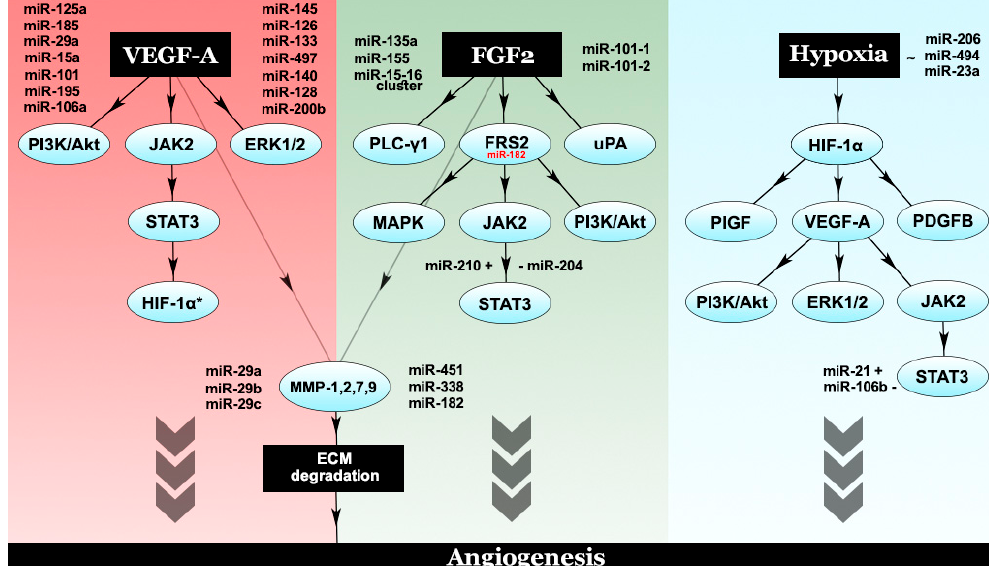
Figure 2. The interplay between different proangiogenic factors and their corresponding modulatory microRNAs. VEGF-A, the chief proangiogenic entity, activates PI3K/Akt, ERK1/2 and JAK2/STAT3. Phosphorylated STAT3 leads to HIF-1 α activation, which further increases VEGF-A levels through an autocrine loop. FGF2 activates PLC- γ 1, uPA and FRS2. Downstream effectors of FRS2 include the MAPK pathway PI3K/Akt and STAT3. Both VEGF-A and FGF2 are capable of activating a number of MMPs, such as MMP-1,2,7,9, which degrade the ECM and promote angiogenesis. Another major player in angiogenesis is considered to be hypoxia, which exerts its molecular effects through HIF-1 α , the hypoxic master regulator. HIF-1 α promotes the expression of a number of proangiogenic factors—PlGF, PDGFB and VEGF-A. Table 1. The main proangiogenic and anti-angiogenic factors, along with a selection of miRNAs that target their genes. In general terms, miRNAs compiled in this table which target the proangiogenic factors are downregulated in the context of angiogenic non-small cell lung cancer (NSCLC), whilst miRNAs that target anti-angiogenic factors are upregulated. The factors were compiled after [15–17] . The gene mutation frequency was obtained through TCGA analysis. miRNAs were selected through a clear methodology: (1) The factors were searched in the miRTargetLink Human tool (Saarland University) which returned a number of miRNAs; only miRNAs with strong evidence were taken into consideration; (2) these miRNAs were inserted into the OncoMir Cancer Database from the Masonic Cancer Center, University of Minnesota which uses TCGA-based data; (3) the tissue type that was taken into consideration consisted of LUAD and LUSC; (4) the resulting heatmaps were used to evaluate the implications of the aforementioned miRNAs.